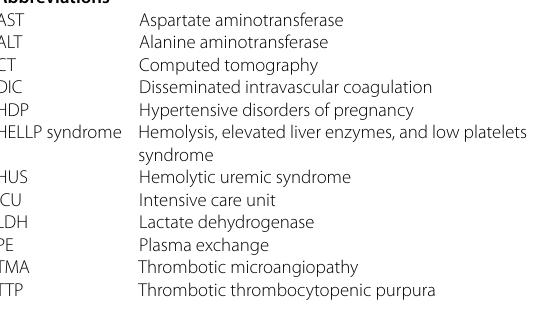
Additional file 2: Supplemental Table 1. Changes in coagulation values. Additional file 3: Supplemental Table 2. Mississippi classification for classifying patients with HELLP syndrome. Acknowledgements Not